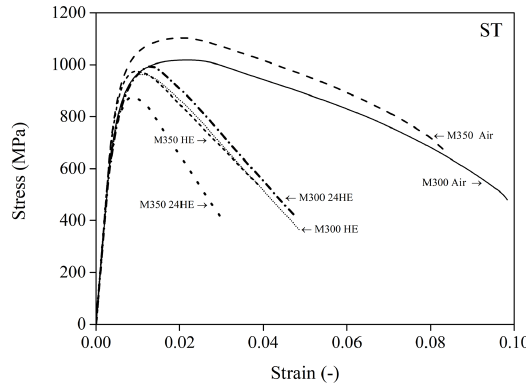
Figure 3. Average stress-strain curves for ST specimens of maraging M300 and M350 in air and under HE conditions after data processing.